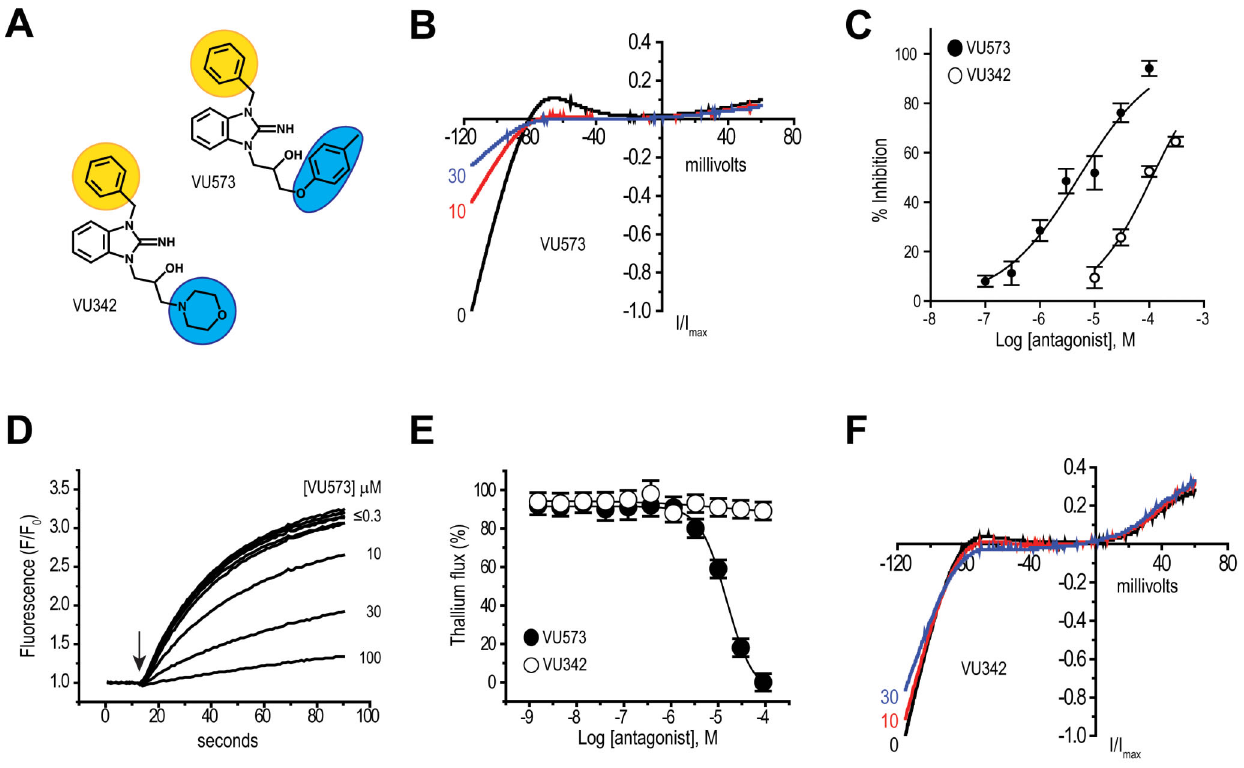
Figure 1. Small-molecule probes of Ae Kir1 expressed in T-REx-HEK-293 cells. ( A ) Chemical structures of the Ae Kir1 antagonist VU573 and inactive analog VU342. The ‘northern’ and ‘southern’ groups are indicated by yellow and blue shading, respectively. ( B ) Normalized Ae Kir1 current- voltage (I–V) relationships illustrating VU573-dependent inhibition at 0, 10, and 30 m M. Cells were voltage clamped at 2 75 mV and ramped between 2 120 mV and + 60 mV. ( C ) Concentration-response curves of VU573 (filled circles) and VU342 (open circles) derived from patch clamp experiments ( n =4–9). The IC 50 of VU573 and VU342 are 5.14 6 1.2 m M and 112 6 1.1 m M, respectively. ( D ) Dose-dependent inhibition of the Ae Kir1-mediated Tl + flux by VU573 ranging in concentrations from # 0.3 to 100 m M. The arrow indicates when Tl + was added to the extracellular bath. ( E ) Concentration- response curves of VU573 (filled circles) and VU342 (open circles) derived from Tl + flux assays. n =2–3 independent experiments, each performed in triplicate. ( F ) Representative I–V relationships showing minimal effects of VU342 on the Ae Kir1-mediated currents at concentrations of 0, 10, and 30 m M. Values in panels C and E are means 6 SEM.